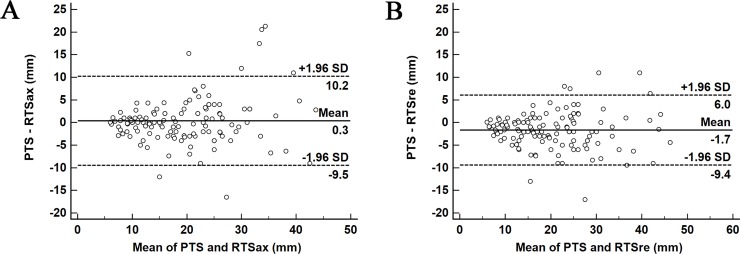
Bland-Altman plots reflecting the differences between pathological tumor size (PTS) and radiological tumor size (RTS), which was measured in the axial image (A) and the multiplanar reformatted image (B). The solid horizontal line indicates the mean difference between PTS and RTS; the horizontal dashed lines indicate the 95% limit of agreement.